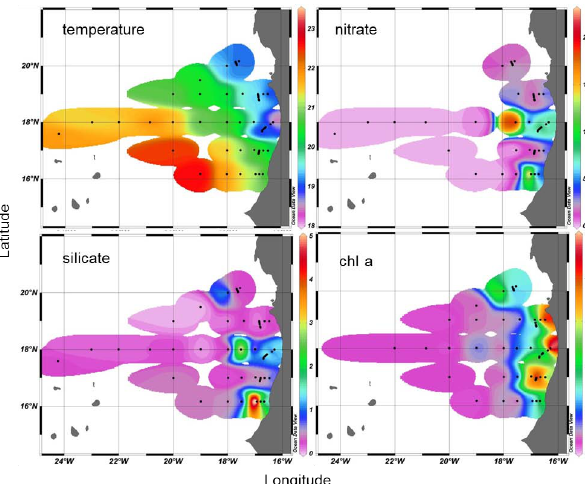
Fig. 2. Surface (5m) distributions of temperature [ ◦ C], nitrate [µmolL − 1 ], silicate [µmolL − 1 ] and chlorophyll- a (chl- a ) [µgL − 1 ] during ATA-03 in February 2008.